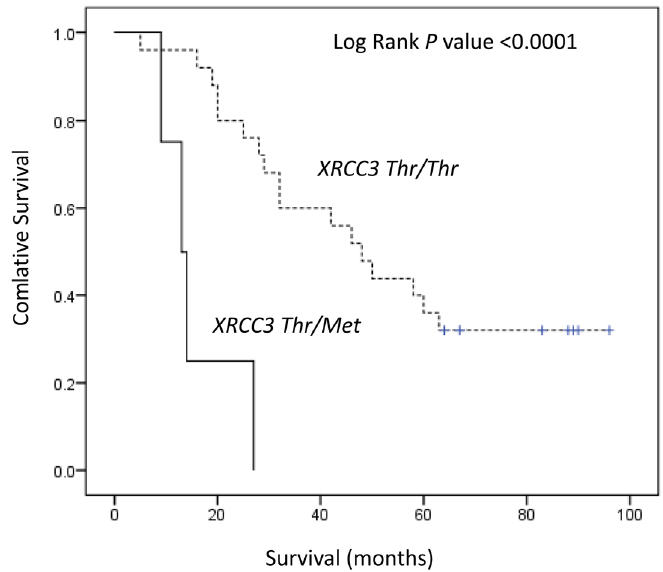
Figure 1. Kaplan–Meier survival curve of lung squamous cell carcinoma patients with the XRCC3 Thr241Met